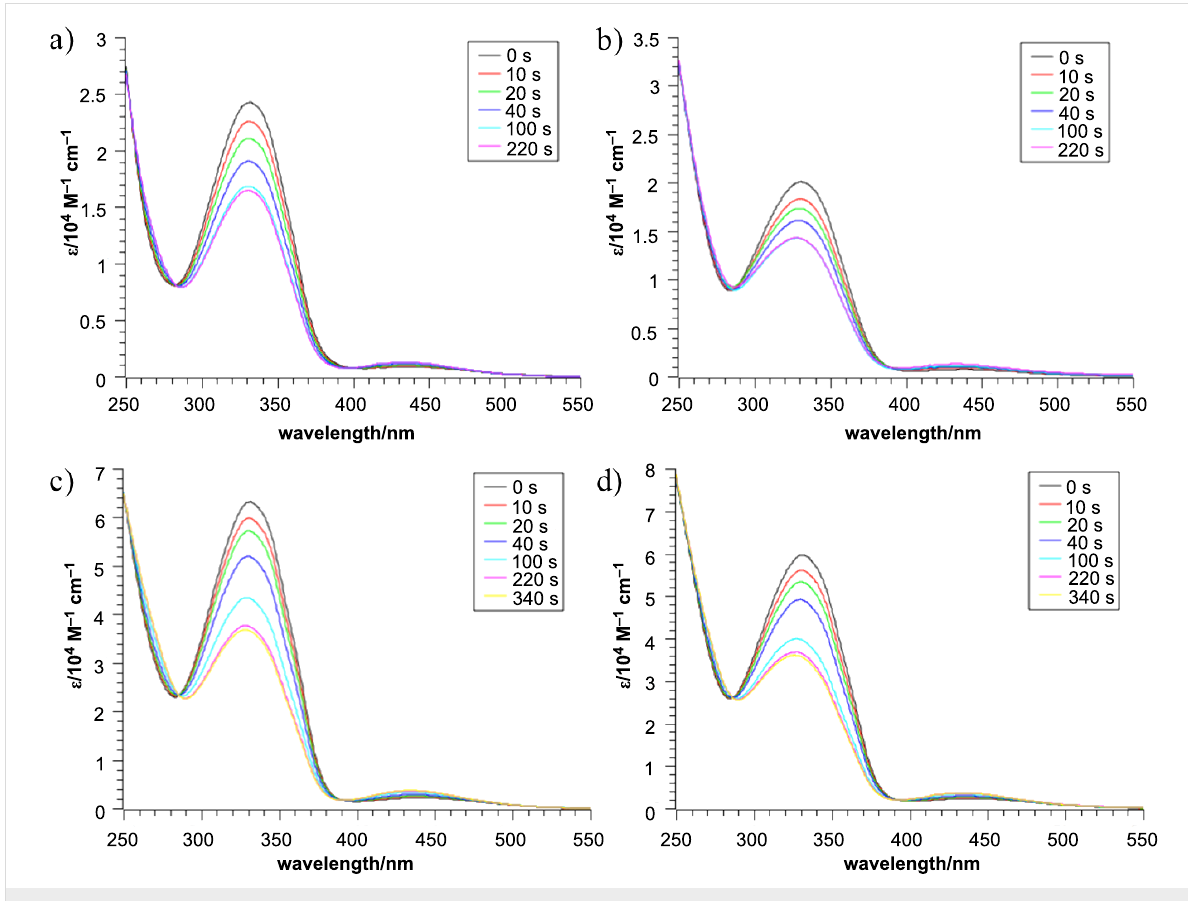
Figure 3: Isomerization studies of compound 13 (a), 15 (b), 16 (c) and 2 (d) (Irradiation at 356 nm in CHCl 3 ).